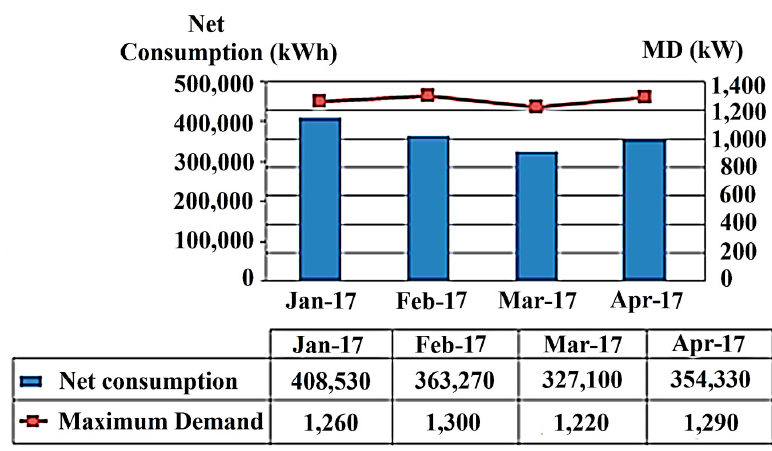
Figure 3. Energy consumption for C1 category commercial sector.